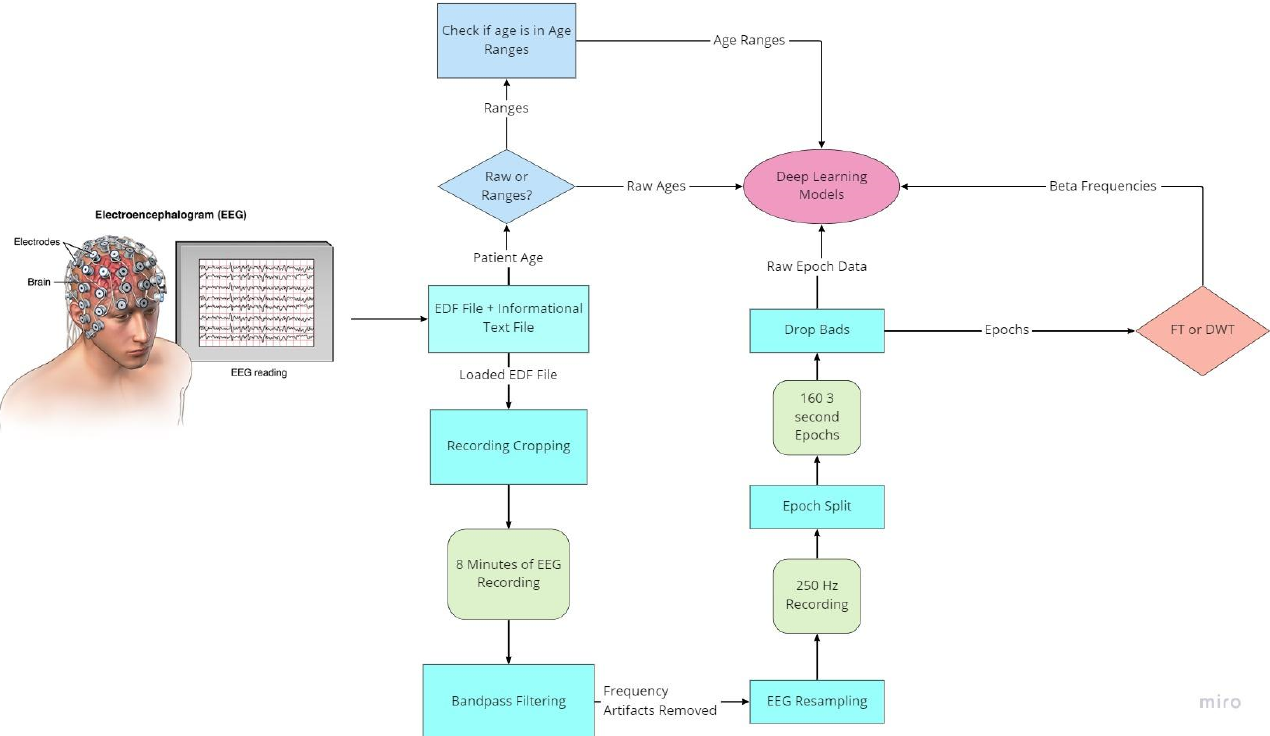
Figure 3. Flowchart of EEG preprocessing.